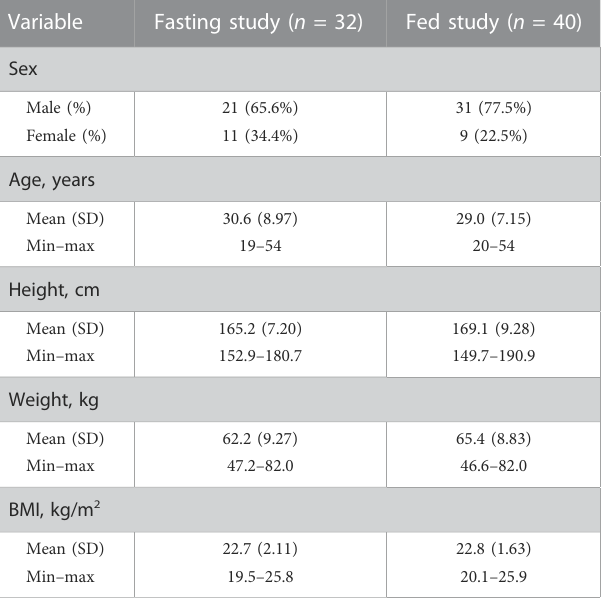
TABLE 1 Baseline demographics and characteristics of study population.